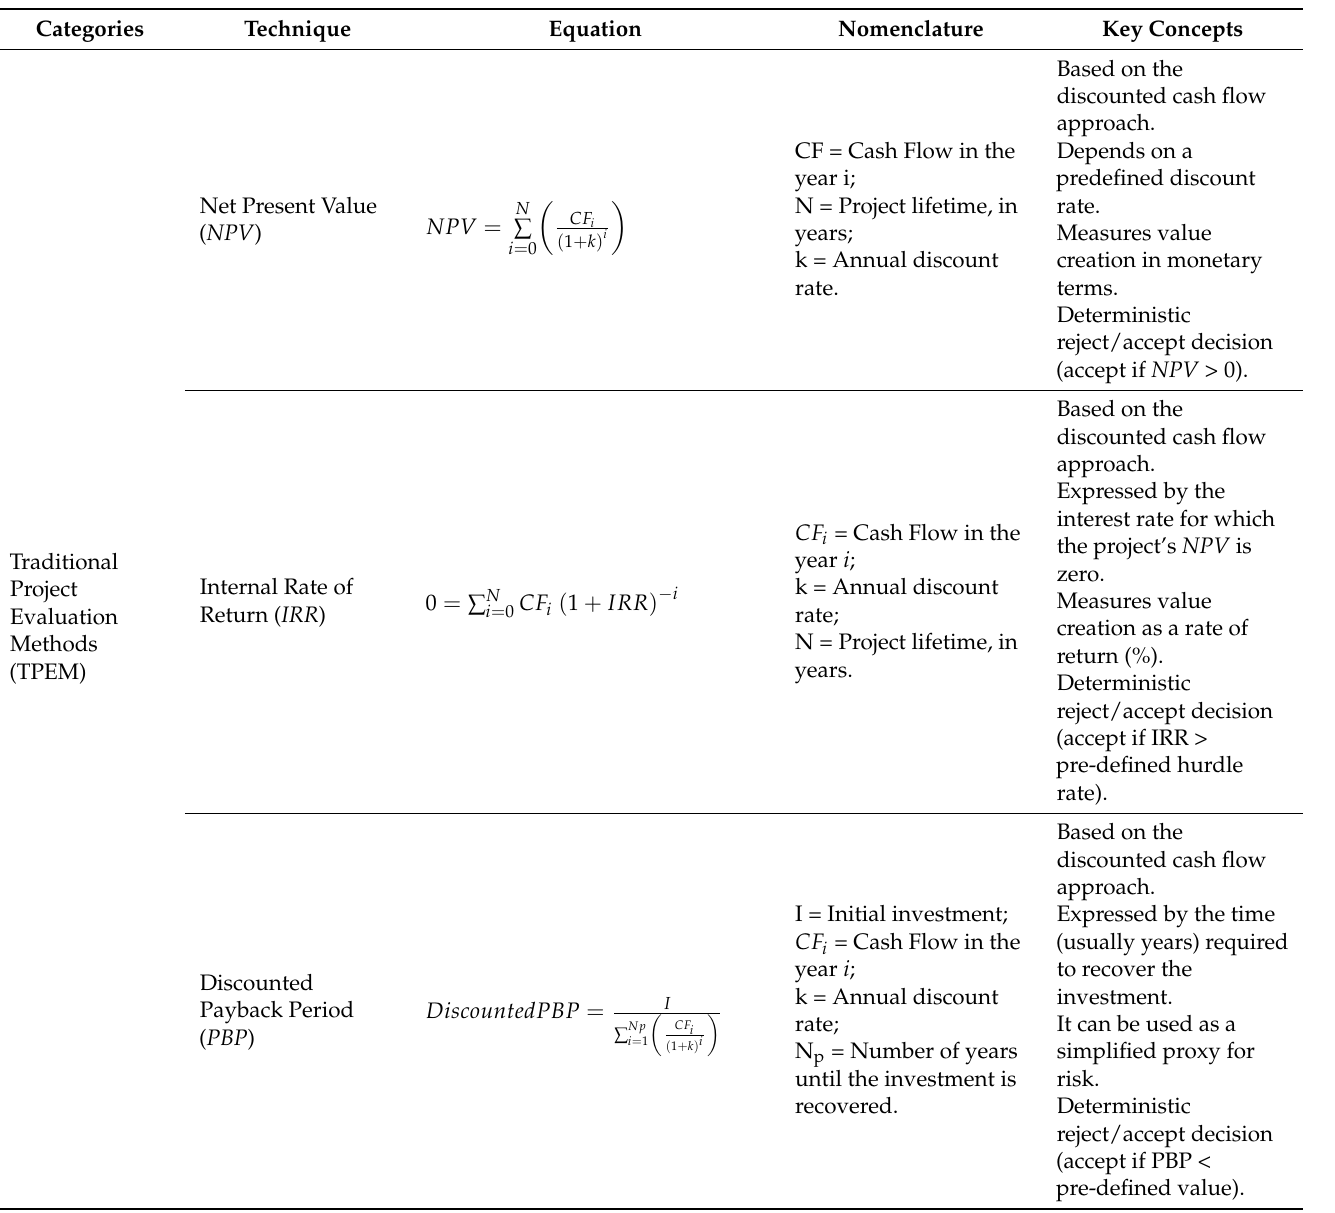
Table 1. Project Valuation